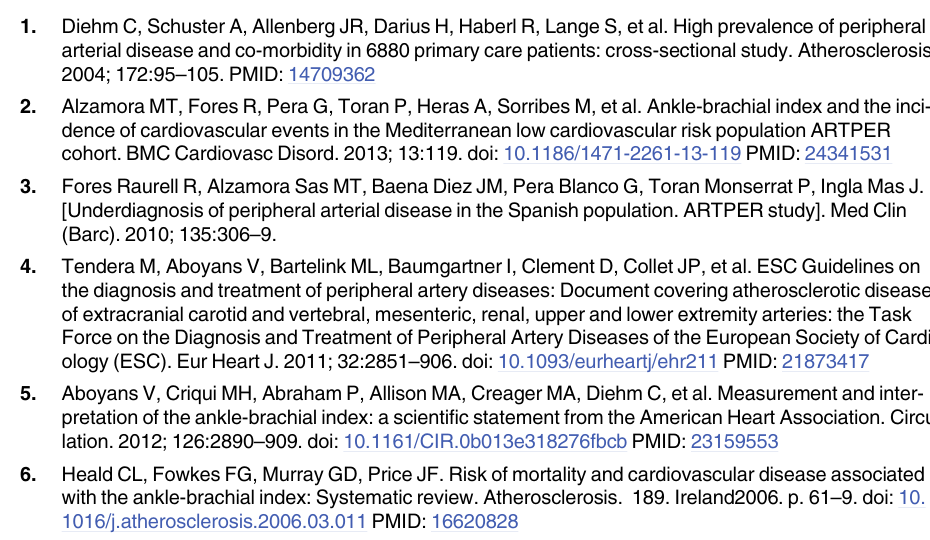
S2 Table. 2x2 Table of reference standard (Doppler) and index test (oscillometer) in ABI determination, excluding calcified legs and considering oscillometric errors as PAD equiv- alents. Each leg is analyzed separately, thus making each leg an independent observation. S3 Table. 2x2 Table of reference standard (Doppler) and index test (oscillometer) in ABI determination, including calcified legs and oscillometric errors as PAD equivalents. Each leg is analyzed separately, thus making each leg an independent